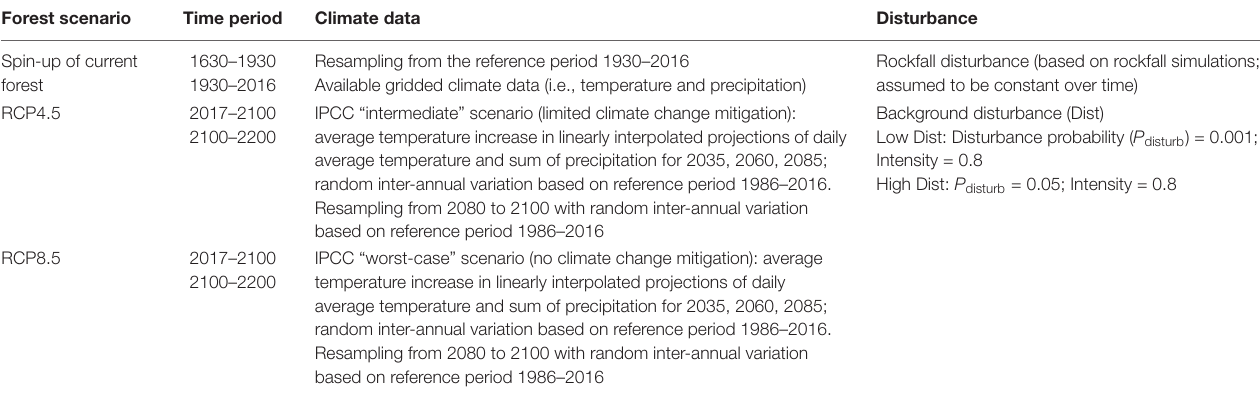
TABLE 1 | Time period, climate data and disturbance regimes [disturbance probability ( P Dist ) and intensity] for the spin-up forest simulation and the future forest